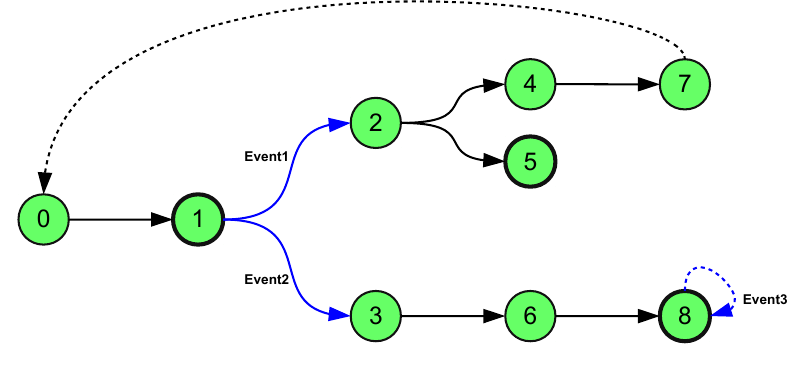
Figure 3. A possible simulation